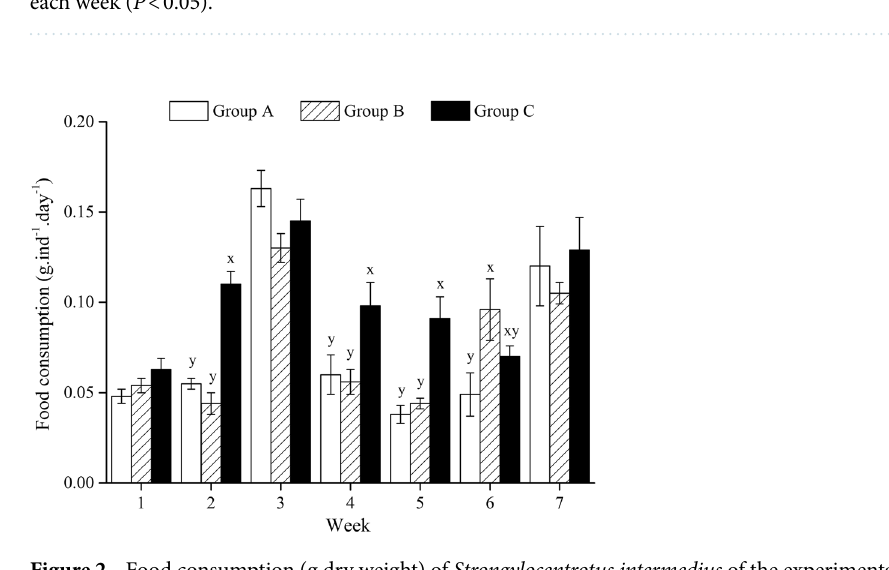
Figure 2. Food consumption (g dry weight) of Strongylocentrotus intermedius of the experimental groups in 7 weeks (mean ± SD, N = 8). Letters above the bars represent significance in each week ( P <